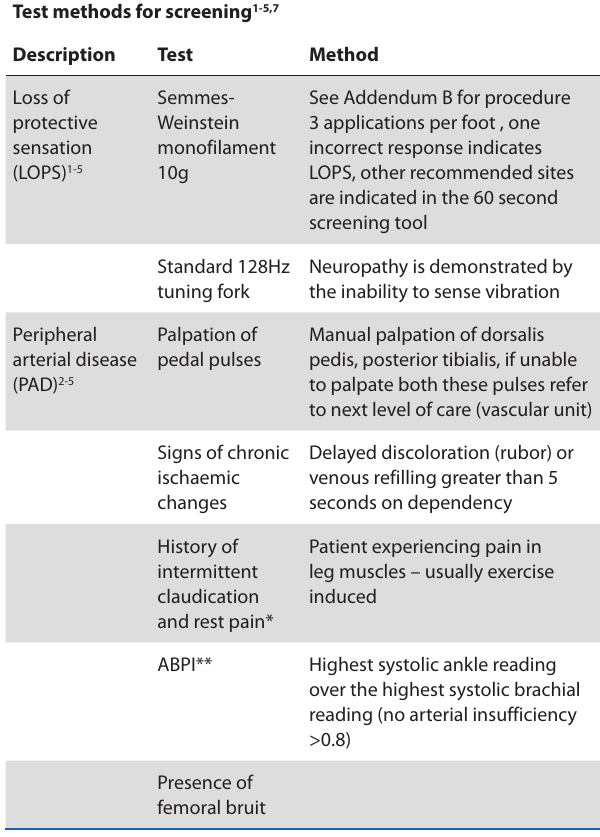
Table 3: Test Methods for risk screening Test methods for screening